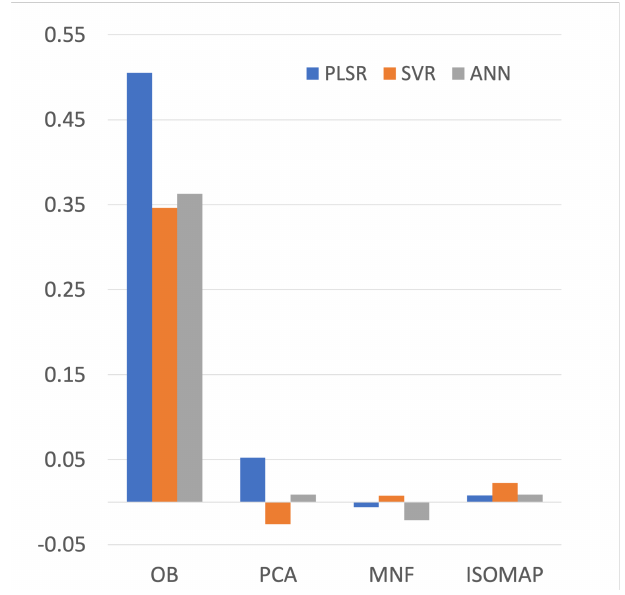
Figure 3. Feature importance of OB, PCA, MNF and ISOMAP for PLSR, SVR and ANN.